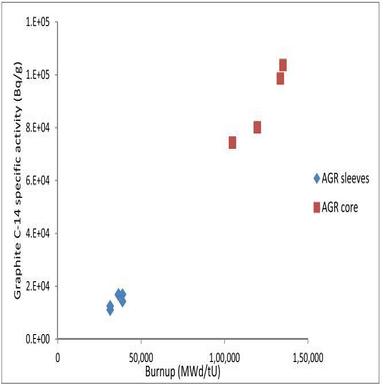
C-14 specific activity in the graphite for the AGR core and sleeve samples as a function of burnup.